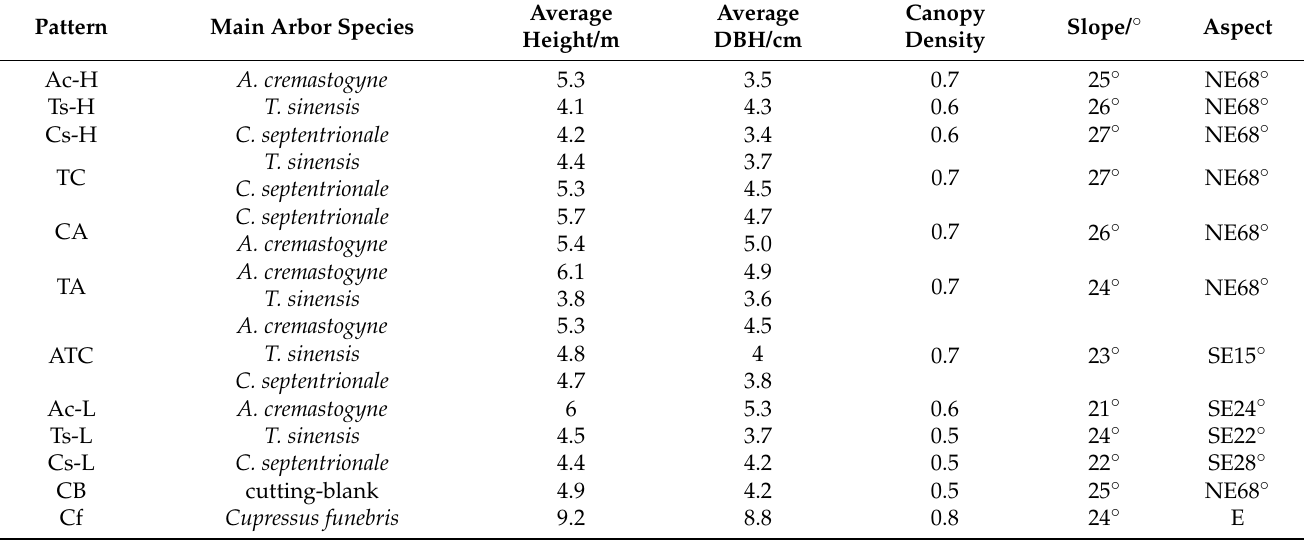
Table 1. Vegetation characteristics of experimental